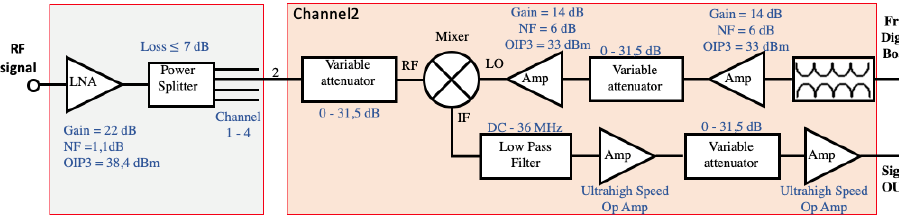
Figure 4. Block diagram of the analog board.